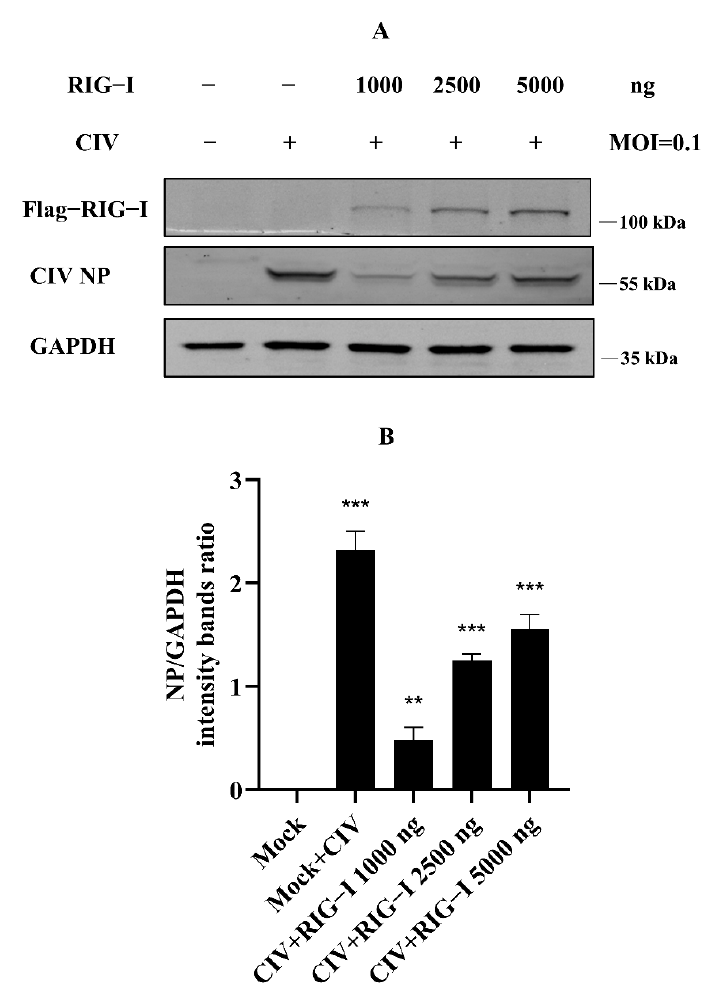
Figure 1. Excessive expression of canine RIG-I (transfection dose more than 2500 ng) weakened the antiviral effect against H3N2 CIV. ( A ) Flag-tagged RIG-I and viral NP was determined by Western blotting, and GAPDH was used as a loading control. ( B ) Protein band intensity of viral NP and GAPDH were used for Western blotting quantification analysis. Samples were analyzed in three independent experiments (** p < 0.01, *** p <